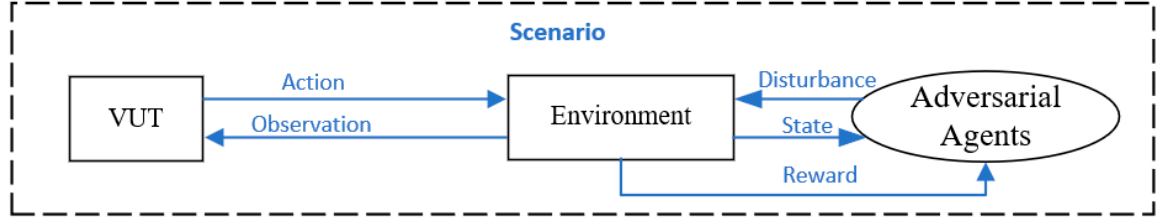
Figure 7. A flowchart of critical scenario generation based on RL [11].